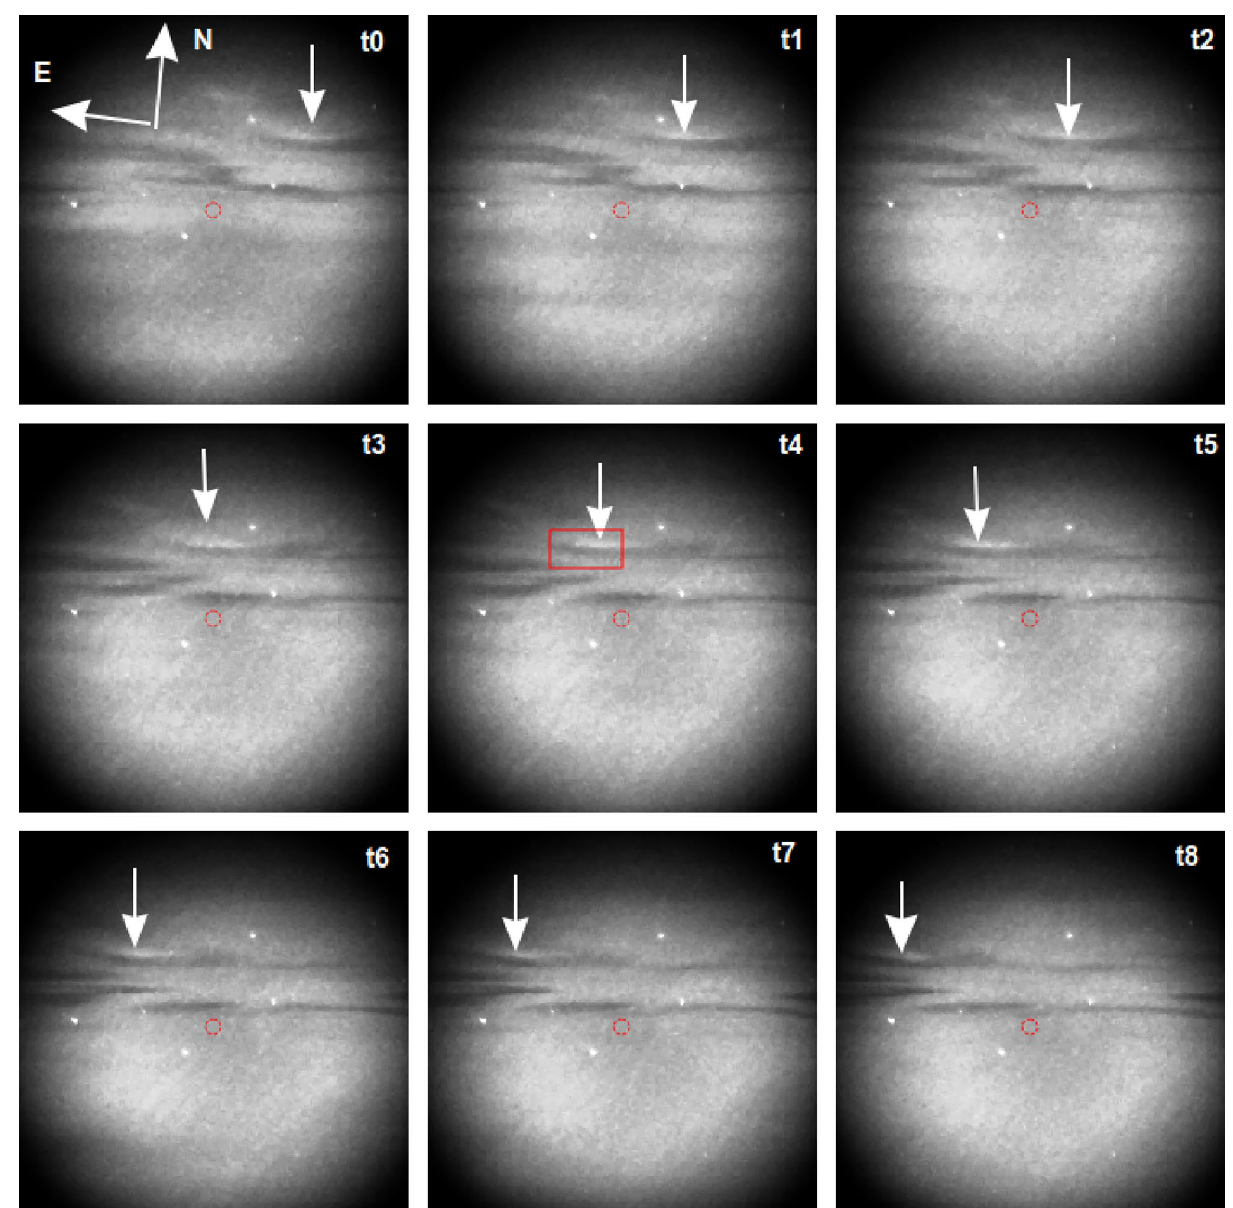
Figure 2. Time lapse of anti-black aurora event (arrow) on 12 March 2016 with the 427.8 nm filter from 22:56:10 to 22:56:34 UT with 3 s steps. The red circle indicates the EISCAT radar pointing direction. The red square denotes the area shown in Fig. 4. The greyscale/brightness range of the image is from black (dark) to white From the raw images, blocks of six pixels were selected to extract the mean energy of the precipitating elec- trons from the black, anti-black and diffuse auroras. By way of example, we present the averaged pixel values from the event at 22:56:19–22:56:28 UT on 12 March 2016 for both the 427.8 and 844.6 nm (see Figs. 2, 3). For 427.8 nm, the average raw pixel value for the anti-black aurora was 1410, the black aurora 1169, and the adja- cent diffuse aurora 1355. The standard deviation is ∼ 33 data numbers. There were no clear background frames available during this evening, so a sample block was taken from a previous evening, 5 March 2016, using the same camera settings. Here the average background pixel value was 817 with a standard deviation of ∼ 37. These values show that we were clearly able to distinguish the three different types of auroras based on their intensities at 427.8 nm. For 844.6 nm, the average values were 1006 for the anti-black aurora, 955 for the black aurora, and 984 for the diffuse aurora. The standard deviation was ∼ 7 data numbers. The background sample from 5 March 2016 was 848 with a standard deviation of ∼ 15. Again, although with lower contrast and data values closer to the dark sky background, we were able to distinguish the different types of auroras based on their intensities at 844.6 nm. The mean value for the dark frames for the EMCCD (427.8 nm) was 94(9) and for the CCD (844.6 nm) 784(6) with standard deviation given in brackets.